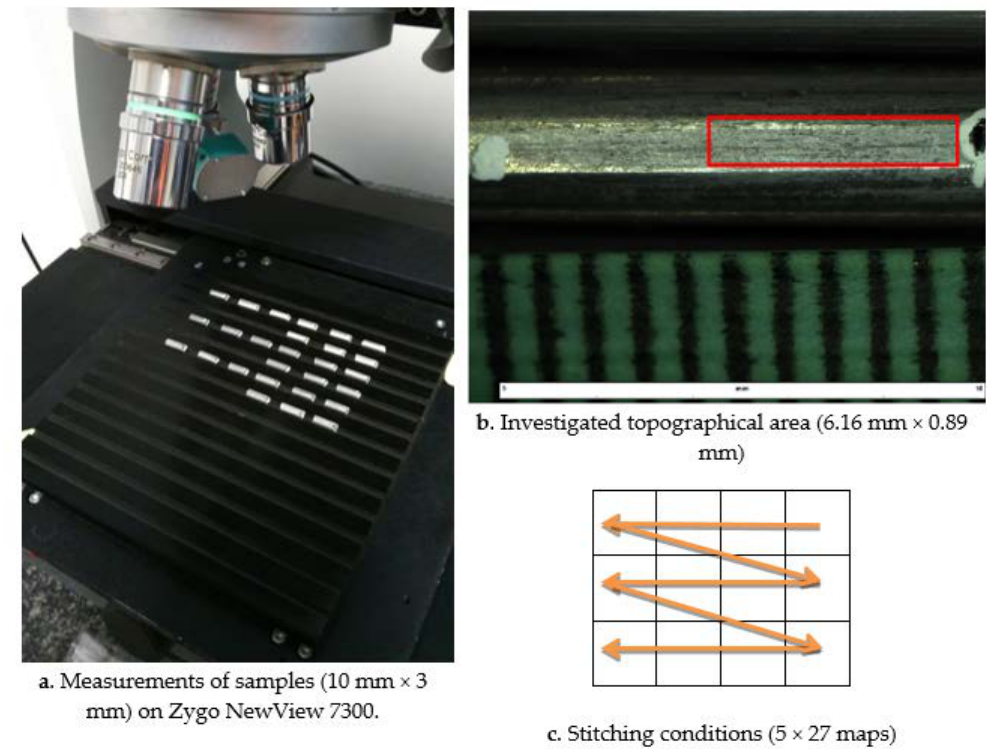
Figure 1. Measurements of rods on Zygo NewView 7300 ( a ) with stitching method ( c ) on a 6.16 mm × 0.89 mm area ( b